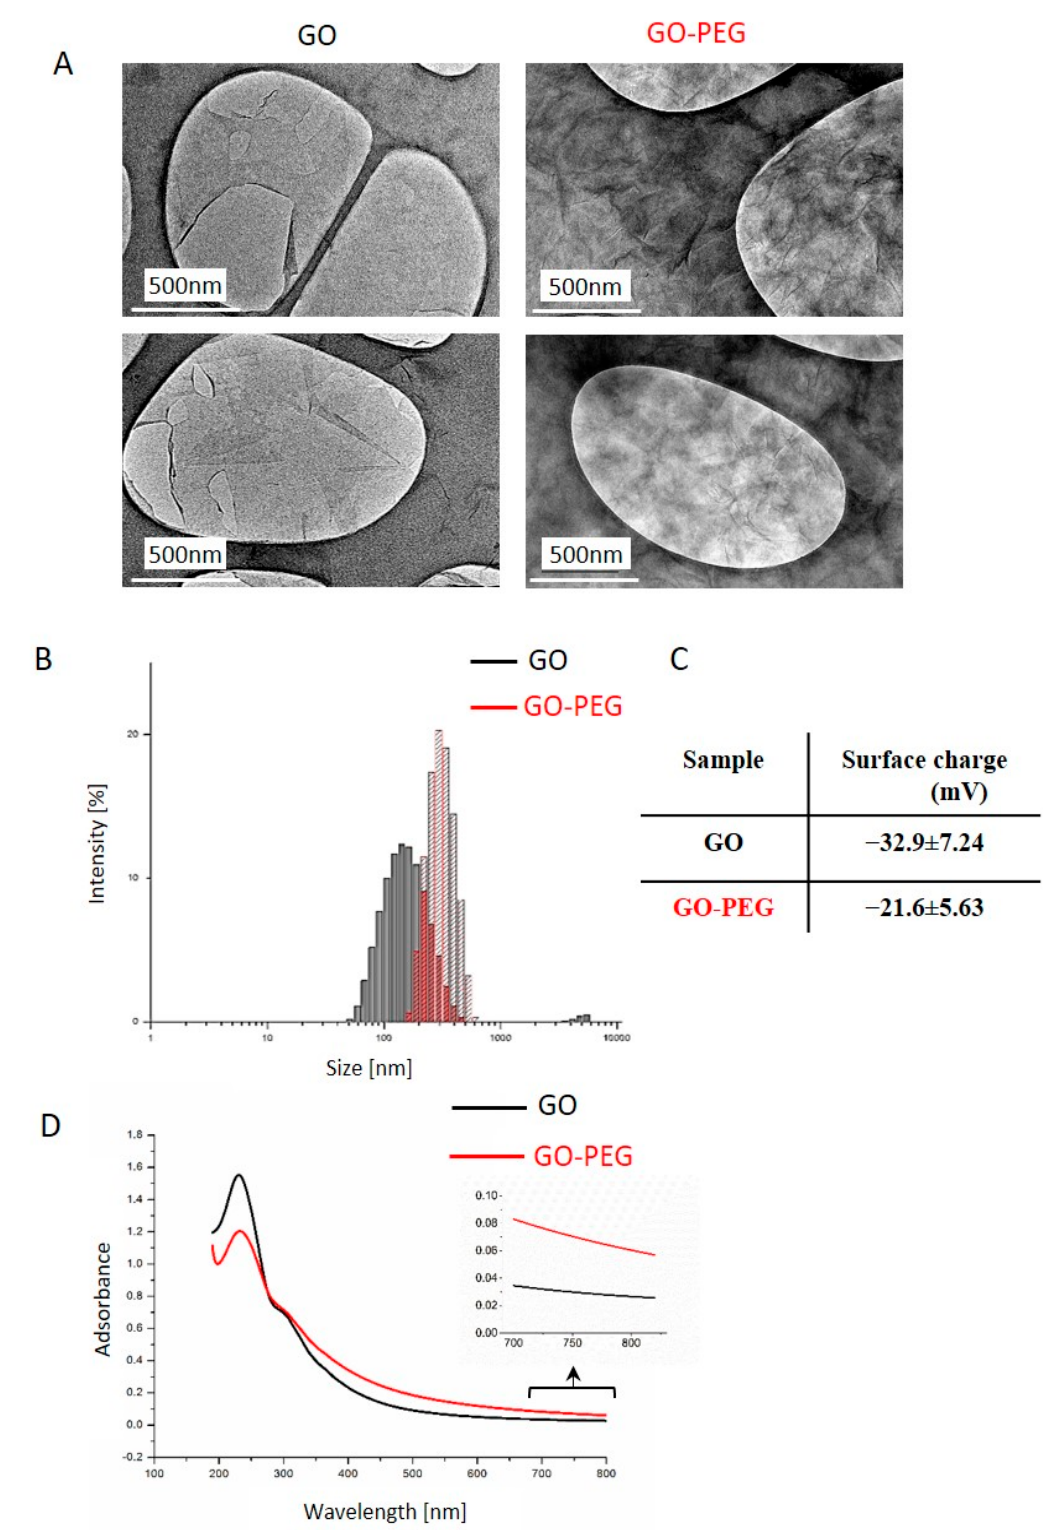
Figure 1. Physiochemical properties of GO and GO–PEG NPs. ( A ) Representative TEM images of GO and GO–PEG water dispersions, sonicated 1 h at 40 Hz ( B ) Size distribution analysis of GO and GO–PEG. Aqueous dispersions of GO and GO–PEG at 1 mg/mL were characterized by DLS after sonication using a particle size analyzer. The histogram shows the average values from triplicate measurements. ( C ) Zeta potential of GO and GO–PEG in water solution. ( D ) Characterization of GO and GO–PEG by ultraviolet-visible spectroscopy with an insert with the enlargement of the NIR region between 700–820 nm. At least three independent spectroscopic measurements were conducted for each sample.